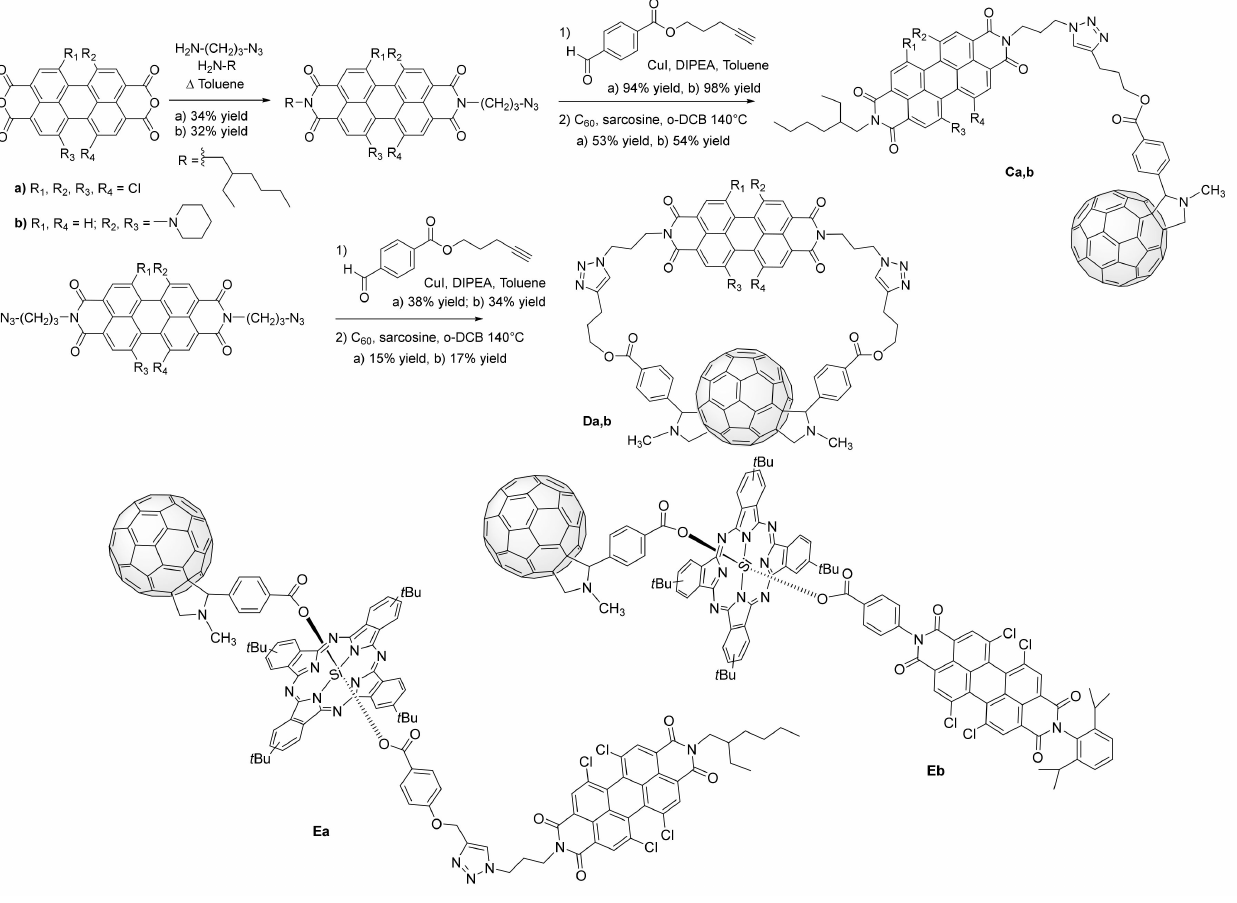
Scheme 3. Synthesis of linear PDI-C 60 dyads C , macrocyclic PDI-C 60 dyad D and extension